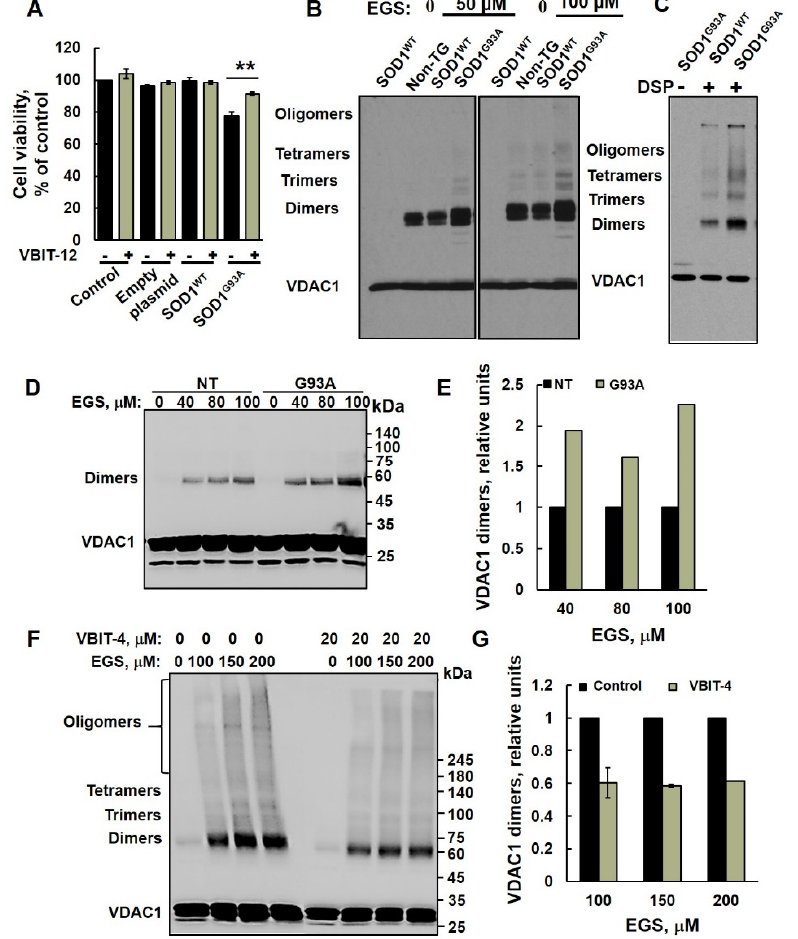
Figure 3. VDAC1 oligomerization is increased in mutant SOD1 G93A spinal cord mitochondria. ( A ) NSC-34 cells were transfected to express the human SOD1 WT , the human mutant SOD1 G93A , or non- transfected (control), and 24 h post-transfection, cells were incubated with or without VBIT-12 (15 µM) for 12 h. A cell viability analysis was performed using the CellTiter 96 AQueous One-Solution cell proliferation assay using a plate reader at 490 nm. ( B , C ) Spinal cord mitochondria (1 mg/mL) from non-transgenic, SOD1 WT or SOD1 G93A rats were incubated for 10 min at 30 °C in 10 mM Tricine, pH 8.2, with the indicated concentration of the crosslinking reagent EGS ( B ) or DSP ( C ). Sample buffer for electrophoresis containing 2-mercaptoethanol, except for DSP (S-S-containing reagent), was added, and the samples were subjected to SDS/PAGE (10% gel) and immunoblot analysis using anti-VDAC1 antibodies. ( D , E ) Spinal cord mitochondria (1 mg/mL, n = 3) from non-transgenic or SOD1 G93A mice were incubated for 20 min at 30 °C in PBS, pH 8.3, with the indicated concentration of EGS, and subjected to SDS-PAGE (10%), immunoblotting ( D ), and quantitative analysis ( E ). ( F , G ) Spinal cord mitochondria isolated from SOD1 G93A mice were pre-incubated with VBIT-4 (10 min, 20 µM) and subjected to cross linking as described in D. Samples were subjected to SDS/PAGE 4–15% gradient gel and immunoblotting using anti-VDAC1 antibodies ( F ) and to dimer quantitative analysis ( G ). VDAC1 dimer levels were quantified using ImageJ software. The positions of VDAC1 monomers, dimers, trimers, tetramers, and higher oligomers are indicated. The results are from triplicates of different biological repeats (n = 3) and are presented as the means ± SEM. ** p < 0.005. 2.3. VDAC1 Oligomerization Is Increased in Mutant SOD1 G93A Spinal Cord Mitochondria Previously, we have demonstrated that apoptotic conditions lead to VDAC1 oligomerization, forming an oligomer with a large channel that enables release of pro- apoptotic proteins, such as cytochrome c, leading to cell death [21,26,51–53]. In order to determine whether the oligomeric state of VDAC1 is affected in ALS pathogenesis, we isolated spinal cord mitochondria from non-transgenic, transgenic